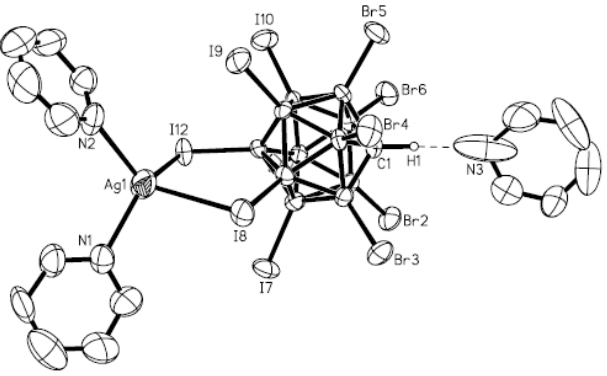
Figure 91. X-ray structure of {(Py) 2 Ag[1-HCB 11 Br 5 I 6 ]·Py}. Reproduced with permission from